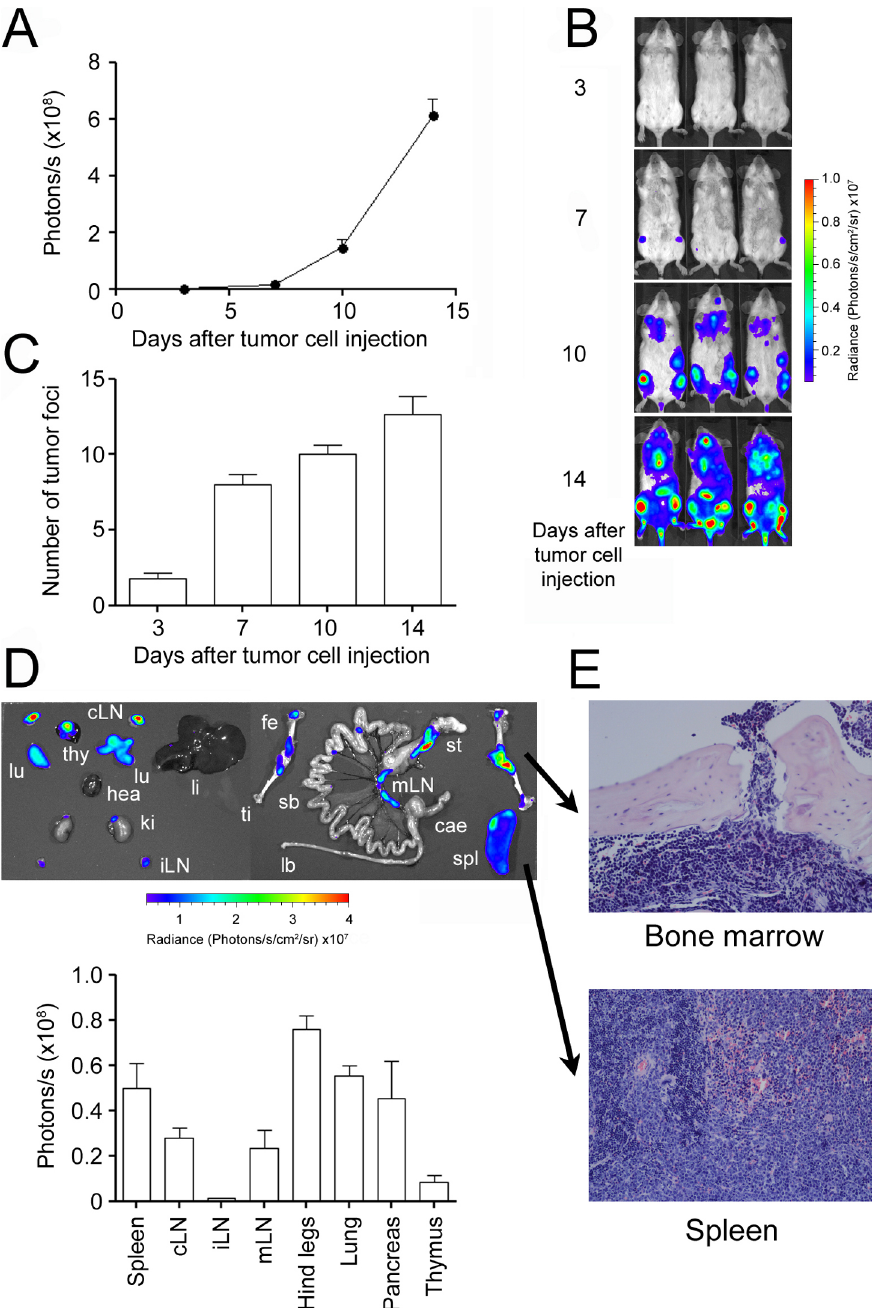
Figure 2. Non-invasive assessment of invivo tumor growth and dissemination. A : 10 5 luciferase-transgenic IM380 tumor cells were injected i.v. into the lateral tail vein into syngeneic BALB/c mice. Tumor growth was assessed by non-invasive in vivo BLI at the indicated time points. B : Representative BLI pictures of tumor-bearing mice. C : Tumor dissemination was determined by counting individual light-emitting tumor foci. D : Upper panel: Representative ex vivo BLI picture of a tumor bearing mouse (lu: lung, cLN: cervical lymph nodes, thy: thymus, hea: heart, ki: kidney, iLN: inguinal lymph nodes, li: liver, fe: femur, ti: tibia, sb: small bowel, lb: large bowel, mLN: mesenteric lymph nodes, st: stomach, cae: caecum, spl: spleen). Lower panel: Evaluation of tumor cell infiltration in individual organs. A–D: (Mean 6 SEM; n=5; shown is one representative experiment out of two). E : Representative eosin and hematoxylinstainings of organs from tumor bearing mice shown in 200 6 magnification.